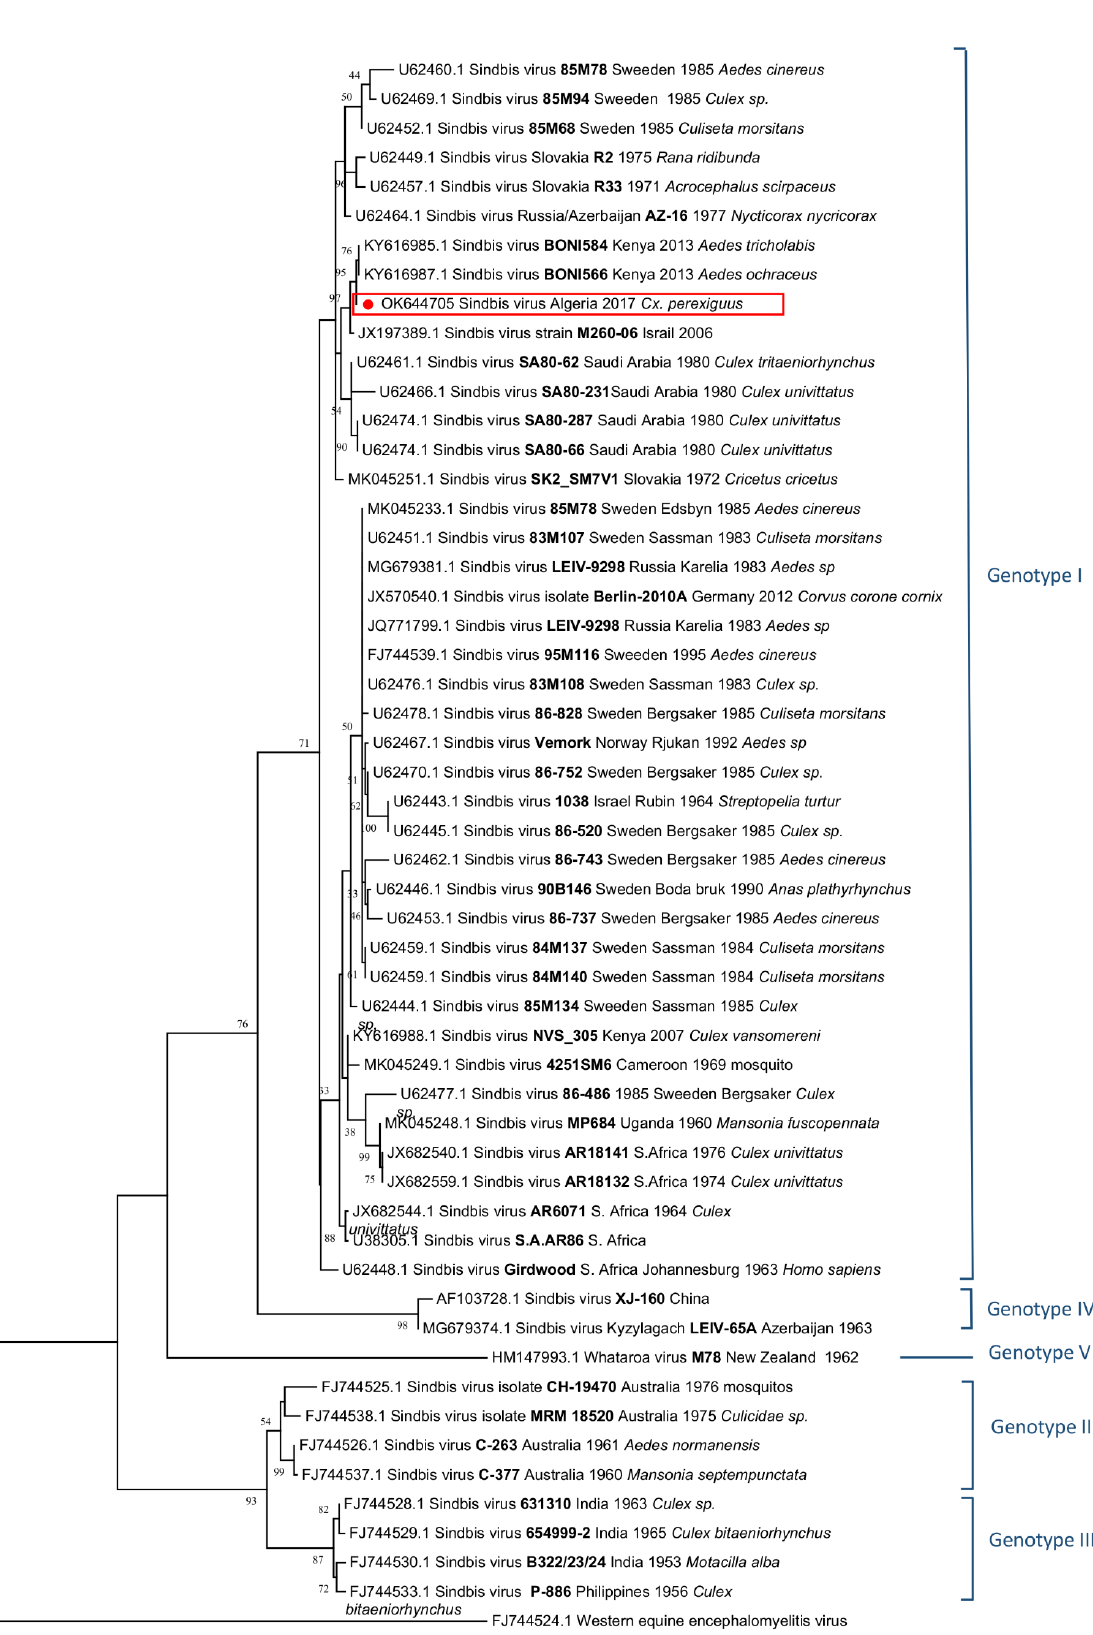
Figure 2. Phylogenetic analysis showing the genetic relationships of SINV genotypes based on partial nucleotide sequencing of the E2